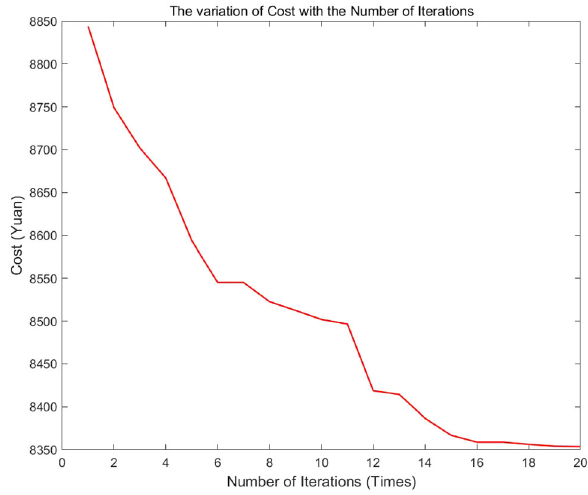
Fig. 8 The variation in cost with the number of